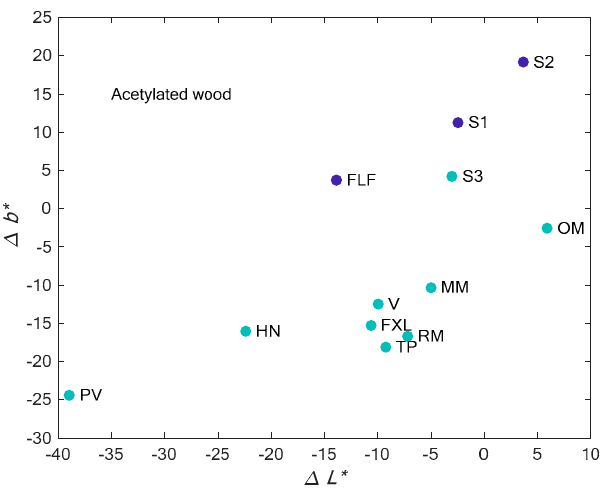
Figure 8. Cluster results plotted on the Δ L * and Δ b * axes. The cluster solution utilizes linkage dis- tances calculated with MANOVA using 18-month Δ L *, Δ a *, and Δ b * values for acetylated wood.